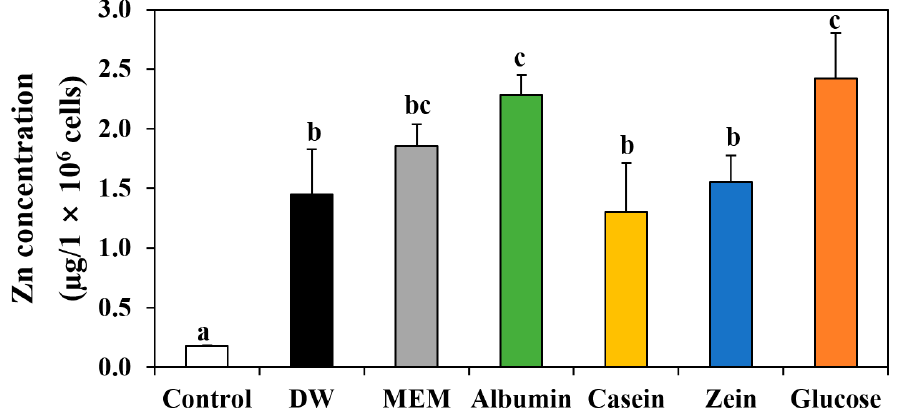
Figure 6. Effect of interactions between ZnO NPs and food proteins or glucose on cellular uptake in Caco-2 cells after 6 h, as determined by analyzing total intracellular Zn levels using inductively coupled plasma–atomic emission spectroscopy (ICP–AES). Cells without ZnO NPs were used as a control. Different lowercase letters (a,b,c) indicate significant differences among control and ZnO NPs interacted with DW, MEM, food proteins, or glucose ( p < 0.05).